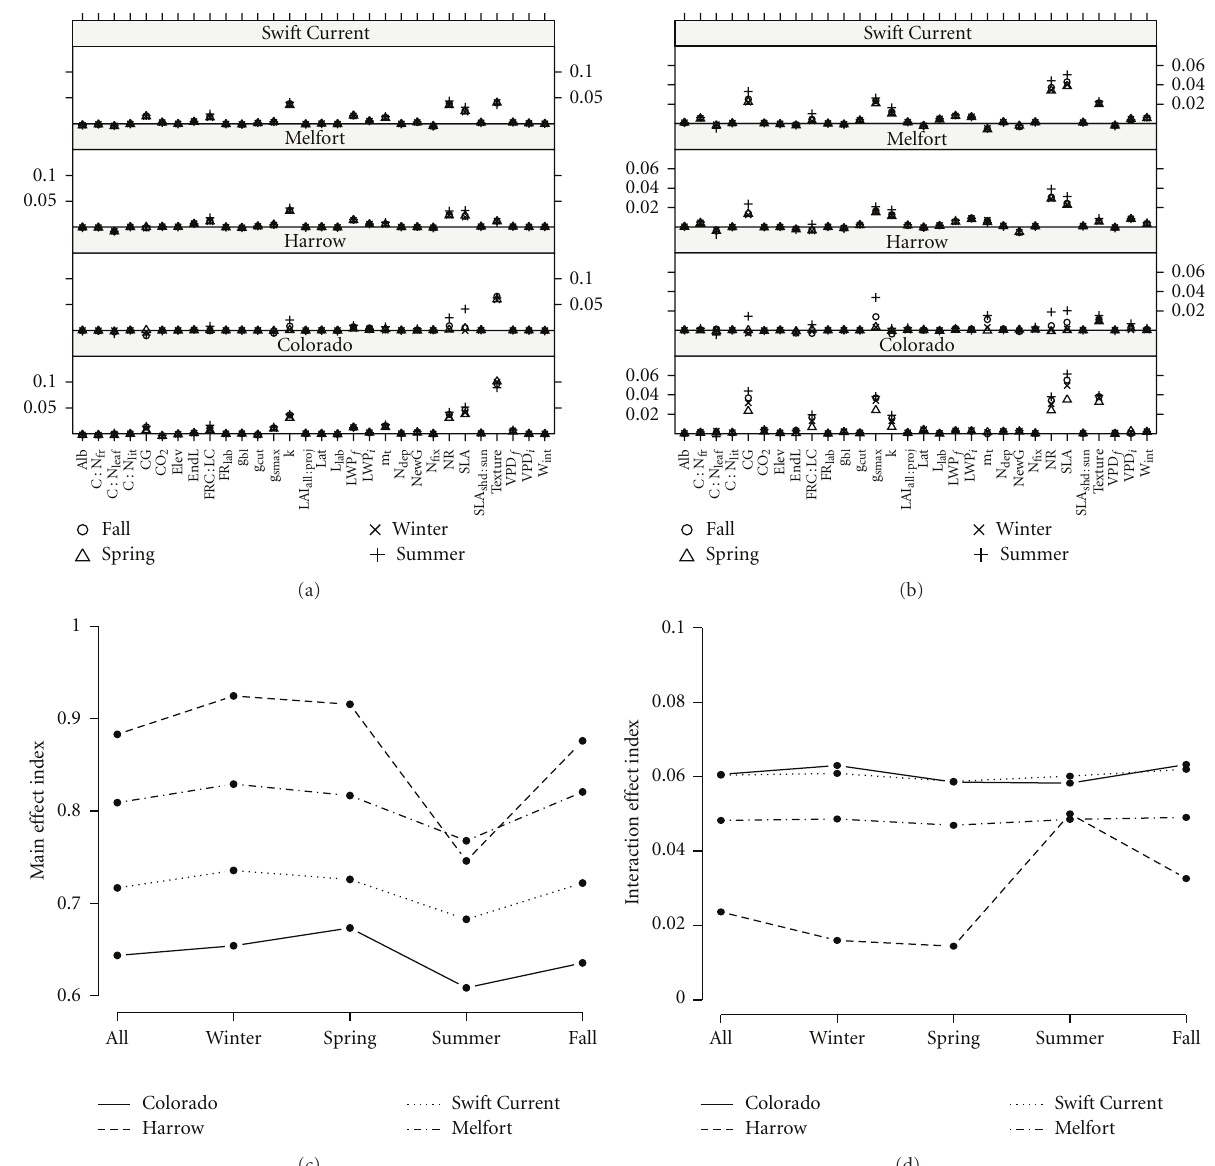
Figure 4: Sensitivity indices for SW based on (depth variable excluded): (a) main e ff ects using all inputs; (b) interaction e ff ects, using all inputs, and SW on depth : (c) main e ff ects, and (d) interaction e ff ects using all inputs.